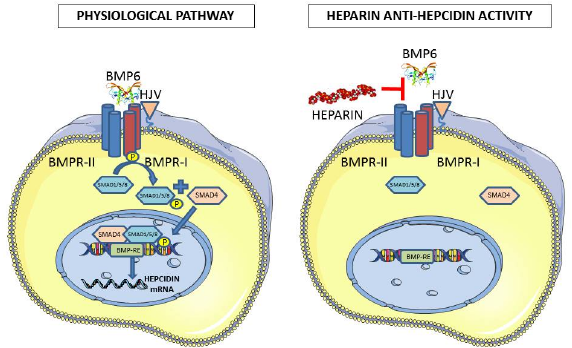
Figure 1. Scheme of the anti-hepcidin activity of heparin. In the physiological pathway, the binding of BMP6 causes the phosphorylation of Type I receptor by Type II receptor, which phosphorylates SMAD1/5/8 that associates with SMAD4, and the complex enters the nucleus to bind to the responsive element on the hepcidin promoter. The anti-hepcidin activity of heparin is thought to act by sequestering BMP6 and interfering with its binding to the receptors.